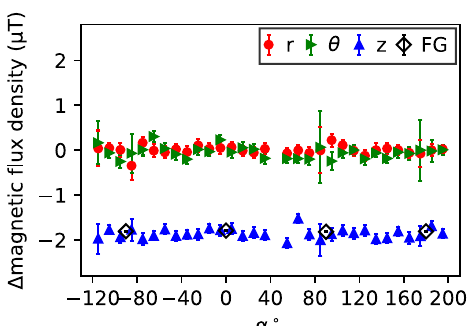
FIG. 8. When the cavity was in the superconducting state, the cavity expelled the applied external magnetic field after phase transition (flux exclusion).